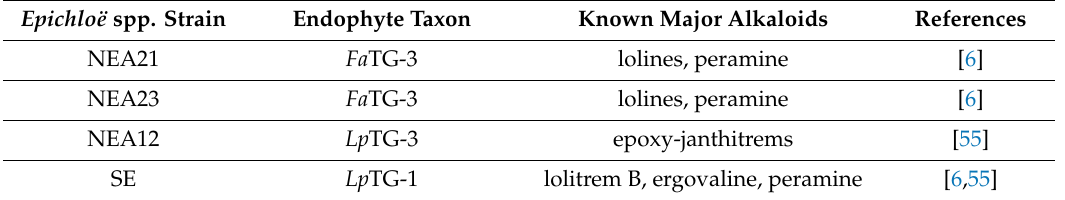
Table 4. Epichloë spp. strains isolated from perennial ryegrass ( Lolium perenne ). Epichloë spp.